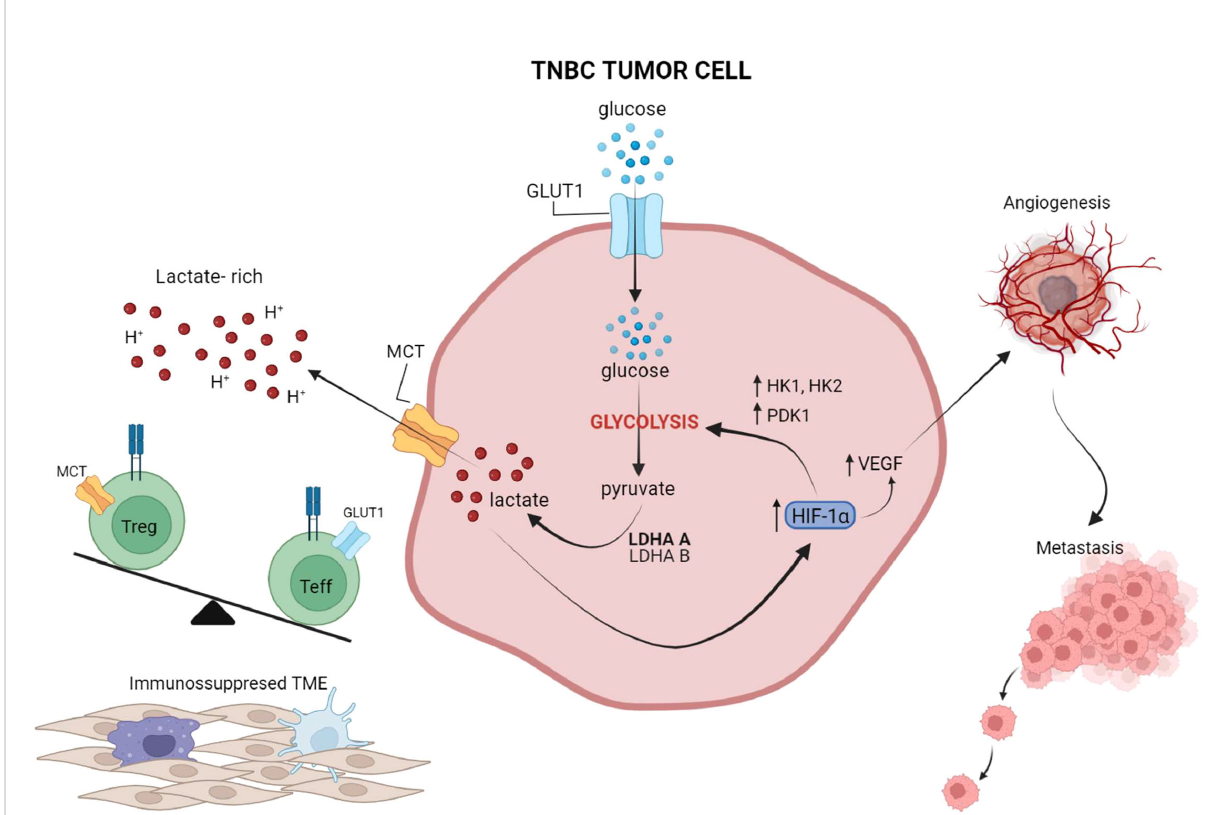
FIGURE 2 The interplay between tumor glycolysis, the immune microenvironment, and hypoxia. In highly glycolytic TNBC tumors, glucose is rapidly depleted from the microenvironment and lactate is abundantly produced through glycolysis and released into the extracellular microenvironment, leading to an increase in acidity. Lactate also activates HIF-1a which in turn further promotes glucose metabolism through glycolysis, by upregulating HK and PDK1, and induces VEGF production for neo-vessel formation and metastasis dissemination. Preclinical studies suggest that this lactate-rich, glucose-low, and hypoxic environment leads to exclusion of Teff from the TME and favors Treg retention and phenotypic integrity. Overall, these effects reinforce an immunosuppressed microenvironment, which in turn leads to suboptimal responses to ICIs. Figure created in